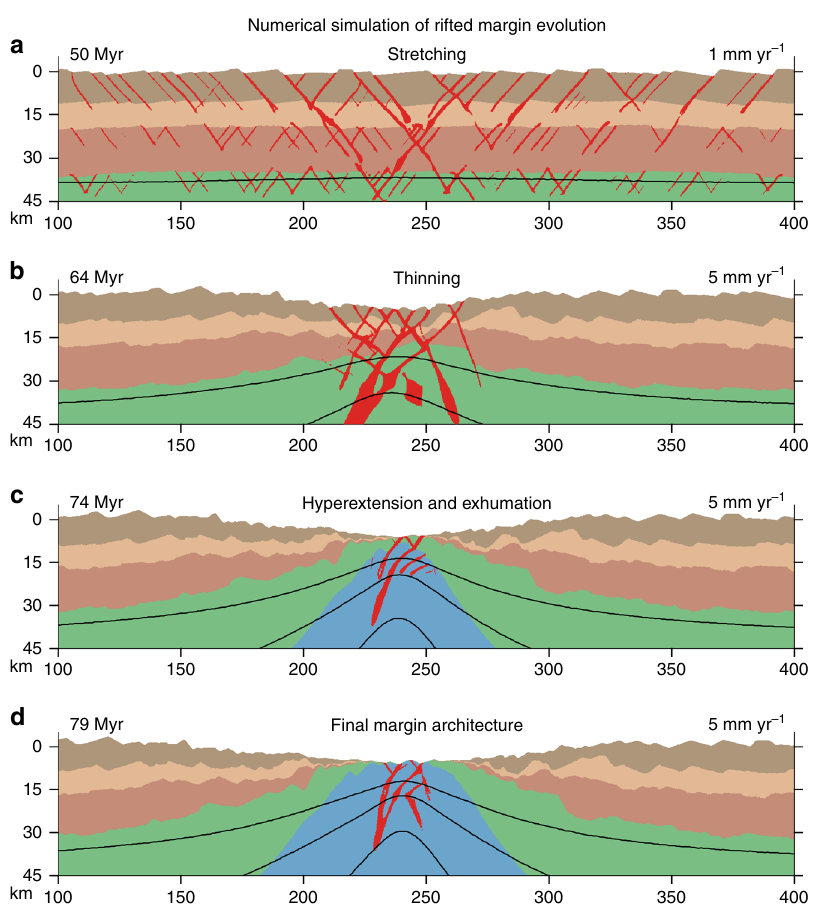
Fig. 2 Modeled phases of rifted margin formation. Numerical model showing phases of continental extension and rifted margin formation that correspond to the conceptual phases of Fig. 1a – d. The initial model contains random small-scale disturbances in its brittle strength to help localize deformation. Images show a 300 by 45 km subset of the total model domain of 500 by 110 km. Black lines mark temperature contours of 600, 900, and 1200 °C. a 50 Myr of slow continental extension at 1 mm yr − 1 causes distributed shear zone formation throughout the crust and upper mantle lithosphere. b – d An increase in velocity to 5 mm yr − 1 progressively localizes deformation towards the model center in the thinning, hyperextension-exhumation and fi nal breakup stage. Red regions highlight strain-rates above 10 − 15.5 s − 1 a , 10 − 14.5 b , and 10 − 14 s − 1 c ,